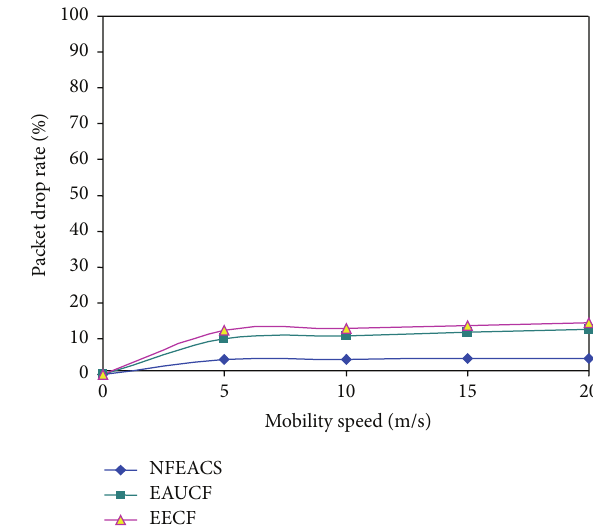
Figure 8: Mobility speed versus packet drop rate.